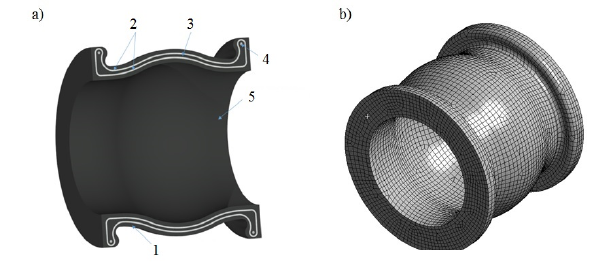
Figure 11: a) geometrical model: 1 – external layer, 2 – reinforce- ment, 3 – mid layer, 4 – wire, 5 – internal layer; b) discretized